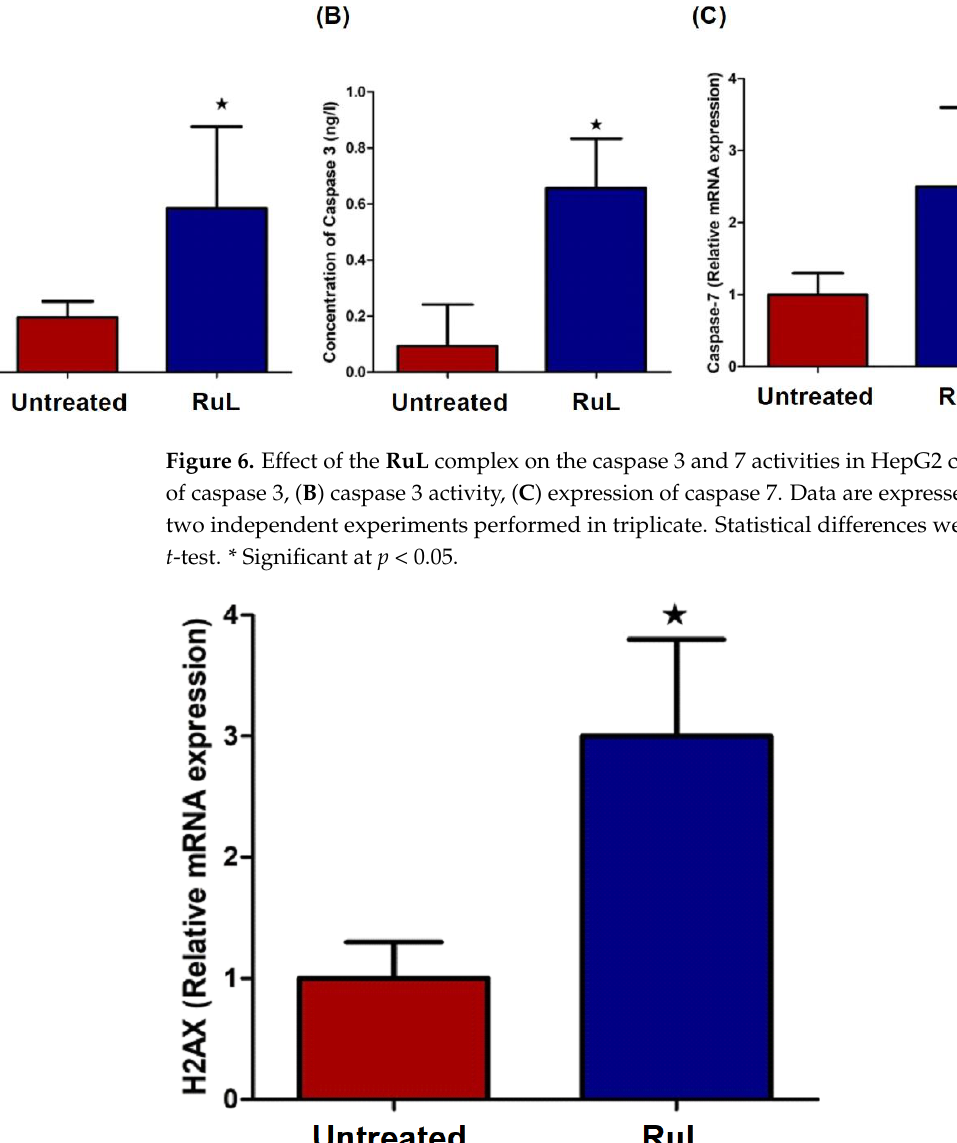
Figure 7. Effect of the RuL complex on H2AX expressions in HepG2 cells as determined by RT-PCR. Data are given as mean ± SD of two independent experiments performed in triplicate. Statistical differences were analyzed with a T -test. * Significant at p < 0.05.